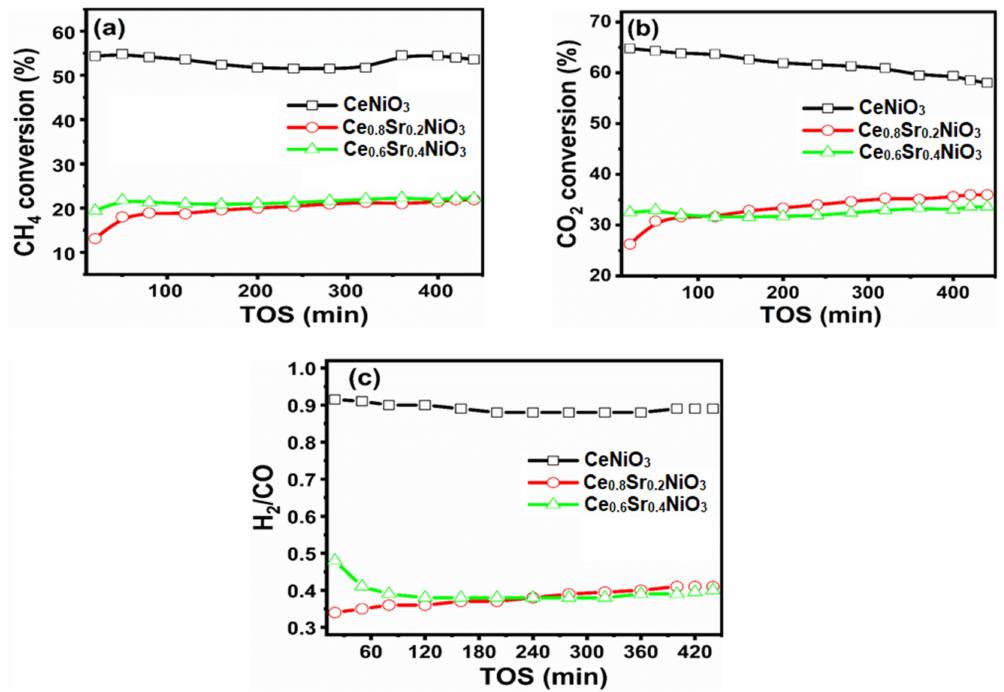
Figure 6. ( a ) CH 4 conversion, ( b ) CO 2 conversion, and ( c ) H 2 /CO ratios versus time-on-stream (TOS)